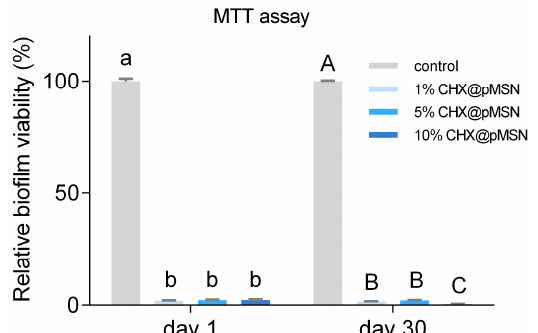
Figure 3. Relative biofilm viability of control, 1%, 5%, and 10% CHX@pMSN groups by MTT assay on ( A ) day 1; and ( B ) day 30. Data are shown as mean ± standard deviation. The groups labeled with the same letters have no significant difference ( p > 0.05).